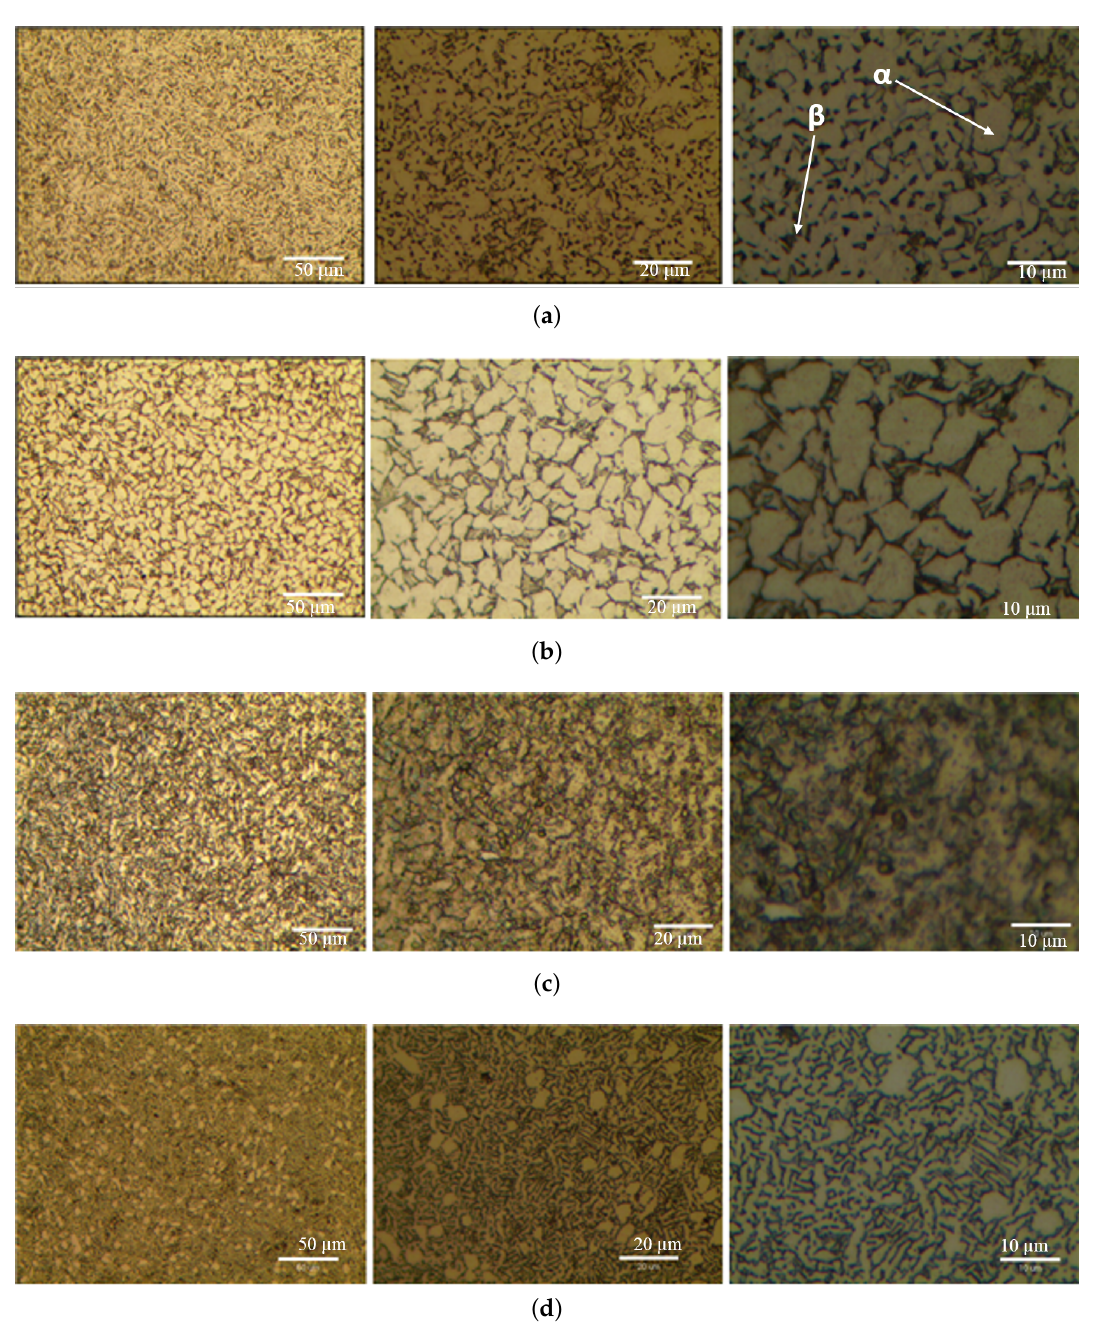
Figure 11. Ti6Al4V microstructure–Optical microscopy (OM). ( a ) Material sample A; ( b ) Material sample A-H; ( c ) Material sample B; ( d ) Material sample